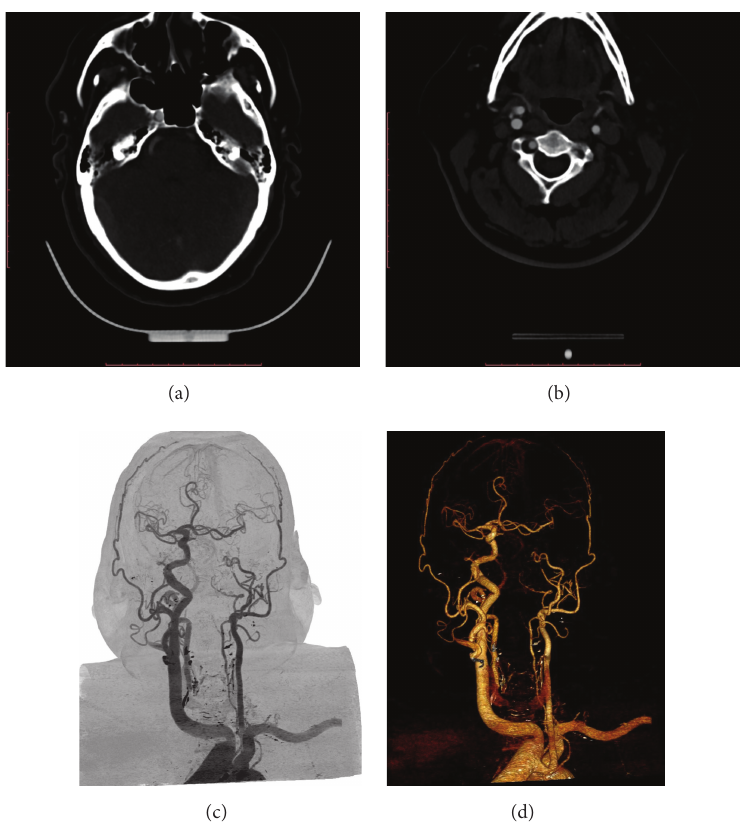
Figure 2: (a) Computed tomographic angiography axial image of the patient shows nonvisualization of the left internal carotid artery with absence of left carotid canal. (b) Computed tomographic angiography axial image of the patient at caudal level shows nonvisualization of the left internal carotid artery. Normal internal and external carotid arteries are seen on the contralateral side. (c) Digital subtraction angiographic image reconstructed by the volumetric rendering techniques shows absent left internal carotid artery with left middle cerebral artery being supplied by the collateral circulation through the anterior cerebral artery and anterior communicating arteries. (d) Three- dimensional reconstruction by the volumetric rendering techniques shows absent left internal carotid artery with left middle cerebral artery being supplied by the collateral circulation through the anterior cerebral artery and anterior communicating